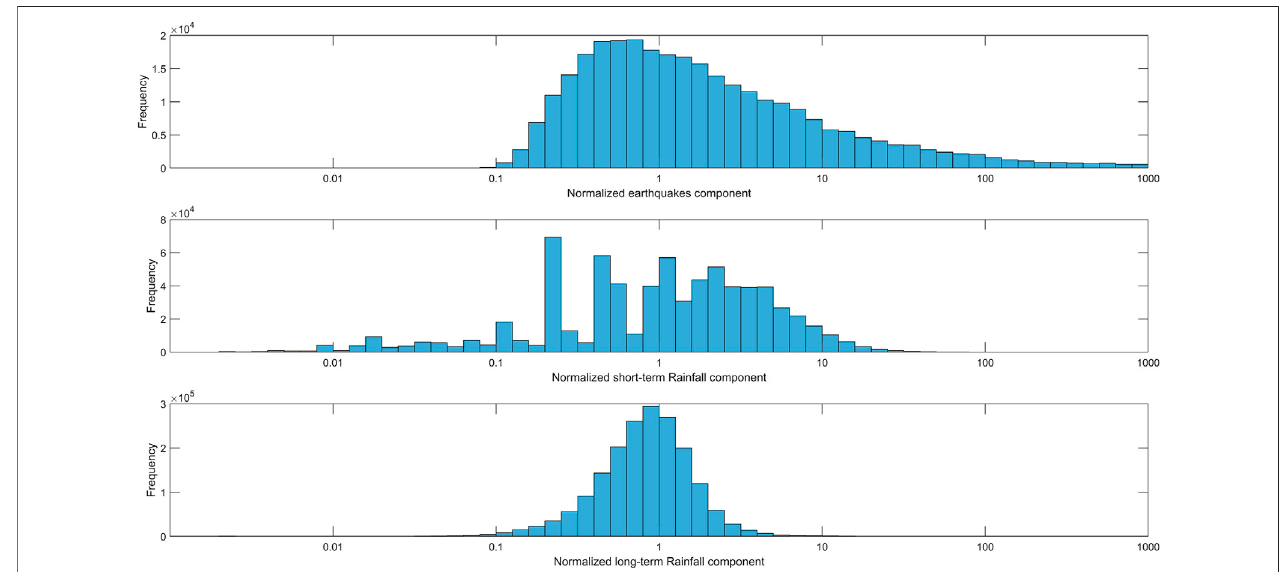
FIGURE 6 | Histograms of the normalized three components.